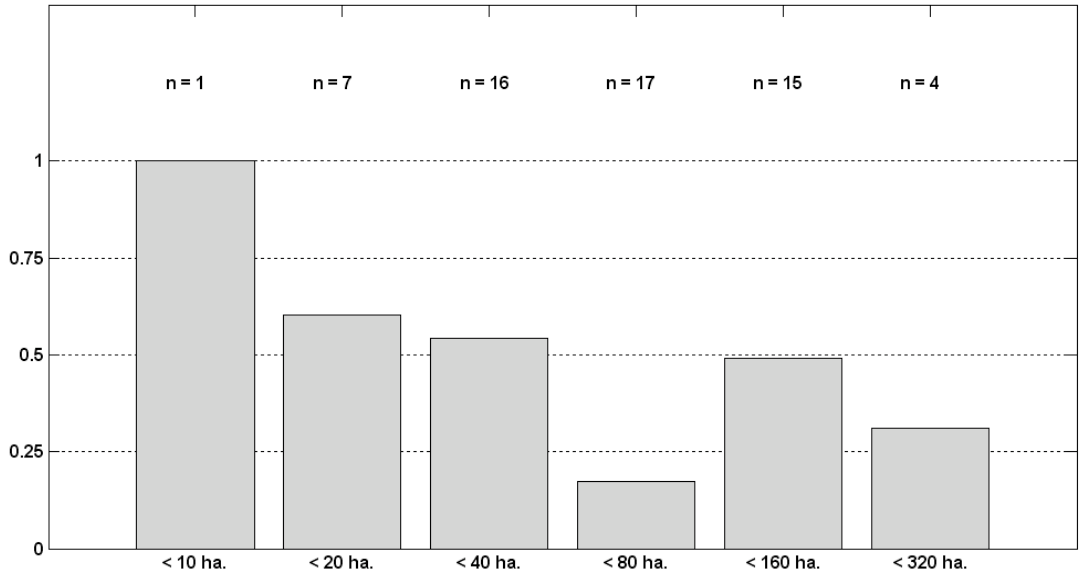
Figure A1.5: Proportion of pasture on property recuperated each year. The n for each bar represents the number of properties of that size in the